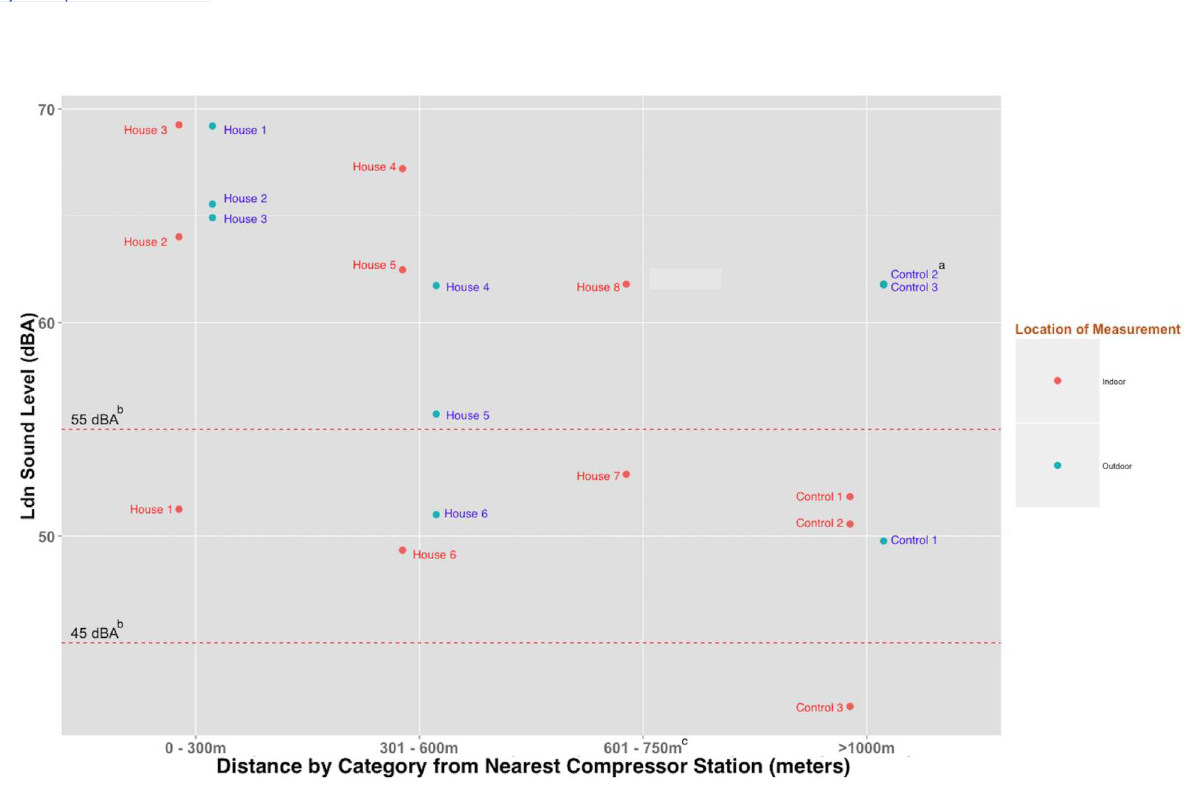
Fig 2. Twenty-four hour A-weighted noise levels indoors and outdoors (L dn, indoor , L dn outdoor ) for each home (dBA) by distance. a Outdoor measurements for Controlhomes 2 and 3 are similar and thus overlap. b The 55 dBA dashedline denotes the 24-hour EPA recommended limit for outdoor noise level to prevent activity interferenceand annoyance. The 45 dBA dashed line denotes 24-hour EPA recommended limit for indoornoise level to prevent activity interference and annoyance. c L dn, outdoor for house 7 and 8 is not includedin the figure becauseequipment failure prevented us from measuring for the full